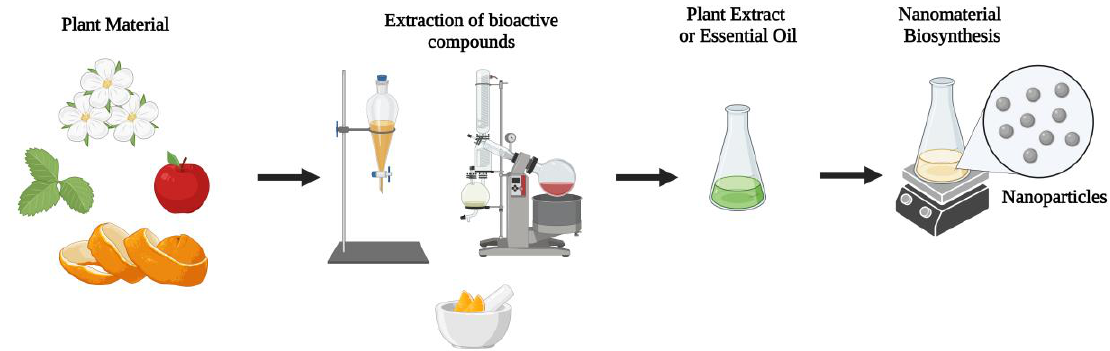
Figure 1. Various compounds can be extracted from different plant sources and applied to different areas, including the biosynthesis of nanomaterials. Different plant parts, such as flowers, fruits, and leaves, can be used to prepare extracts or oils. Various techniques can be employed, such as maceration and extraction using a rotary evaporator, affecting which composts will be efficiently extracted from the plant material. The plant extracts or essential oils produced can be used to synthesize nanomaterials through different protocols that may or may not involve heating.